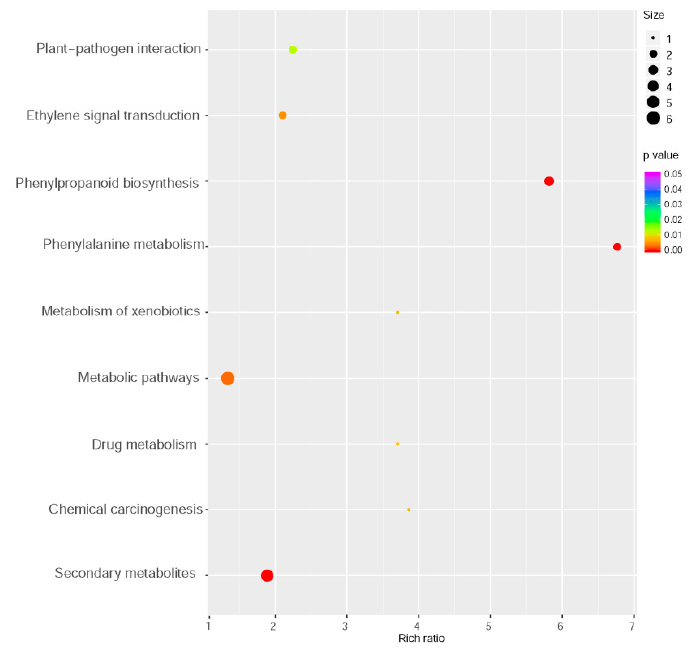
Figure 5. Kyoto Encyclopedia of Genes and Genomes (KEGG) enrichment analysis of differentially expressed genes between the WT and MYB102-OX3 lines. Size and color of the bubble indicated the amount of DEGs enriched in pathway and enrichment significance, respectively.